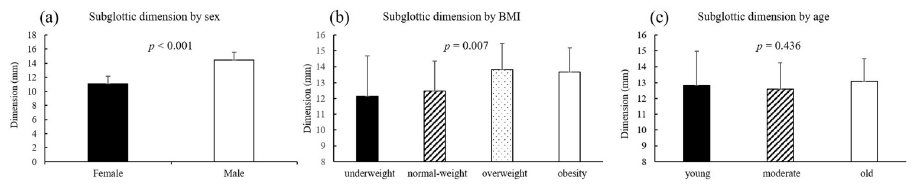
Fig 2. Comparison of subglottic diameter stratified by (a) sex, (b) BMI, and (c) age.